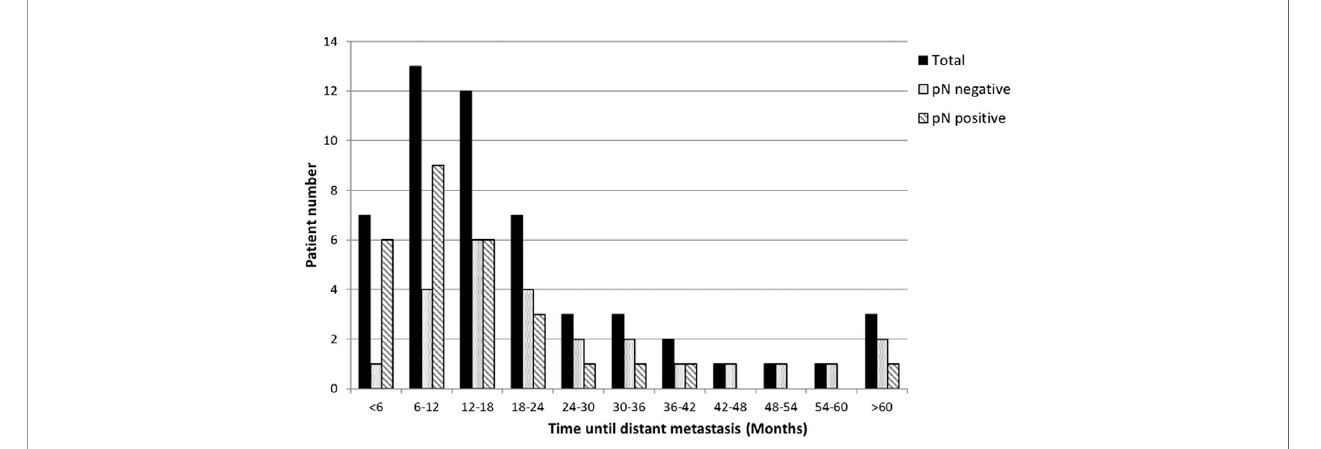
FIGURE 3 | The distribution of time until distant metastasis. Most (84.9%, 45/53) of the DM events occurred within the fi rst 3 y (nodal-negative group, 76% [19/25]; nodal-positive group,